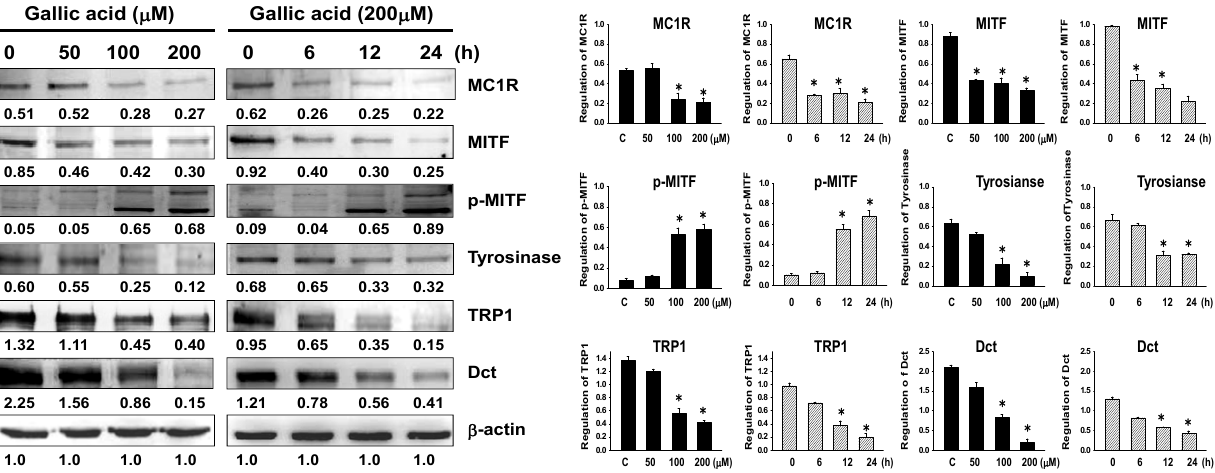
Figure 3. Expressions of melanogenesis-related proteins in B16F10 cells with gallic acid treatment. Western blotting data show the changes in MC1R, MITF, p-MITF, tyrosinase, TRP1, and Dct expressions in B16F10 melanoma cells treated with gallic acid at different concentrations (0–200 µM) for 24 h and treated with 200 µM of gallic acid at different times. β -Actin was used as the protein loading control. Statistical results represented as Means ± SEM ( n = 3) by ANOVA with the Tukey-Kramer test (* p < 0.001 compared with the